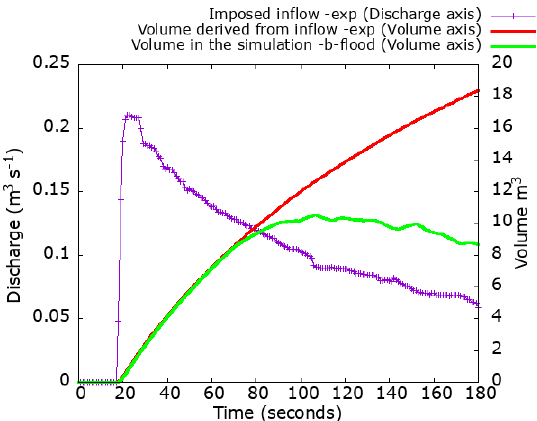
Figure 8. Hydrograph of the imposed inflow on the left boundary. Comparison of the volume of water in the simulation and the exper- imental